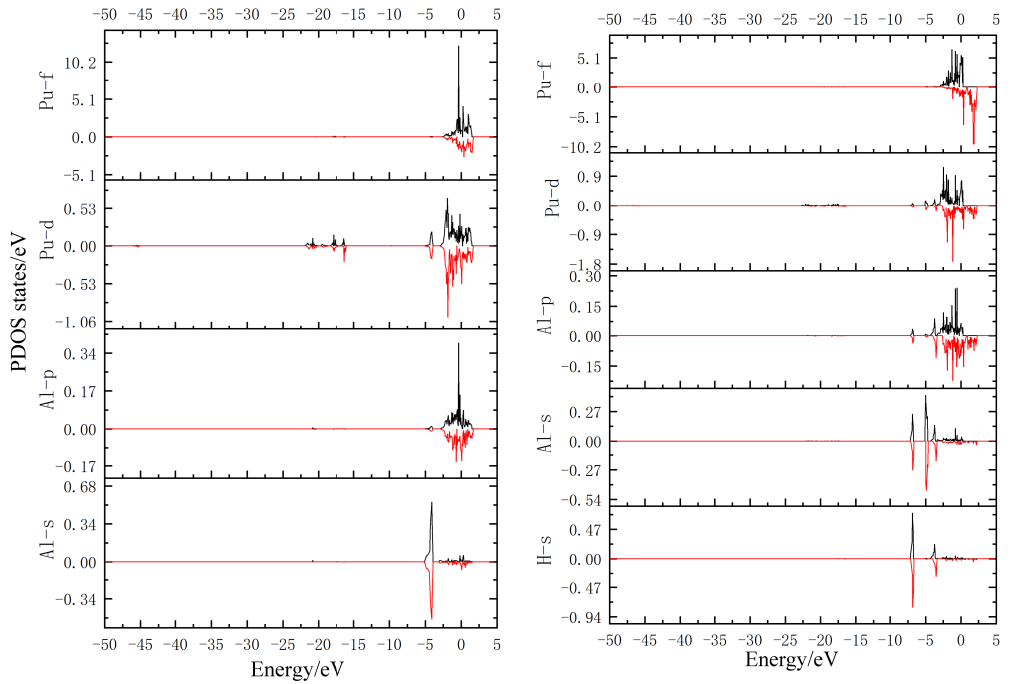
Figure 12. PDOS of Pu-Al system without H adsorbed ( left ), PDOS of Pu-Al system with H adsorbed ( right ). (Black and red represent spin up and down respectively). Table 3. Surface atom charge transfer in Pu-Al system without H absorbed.